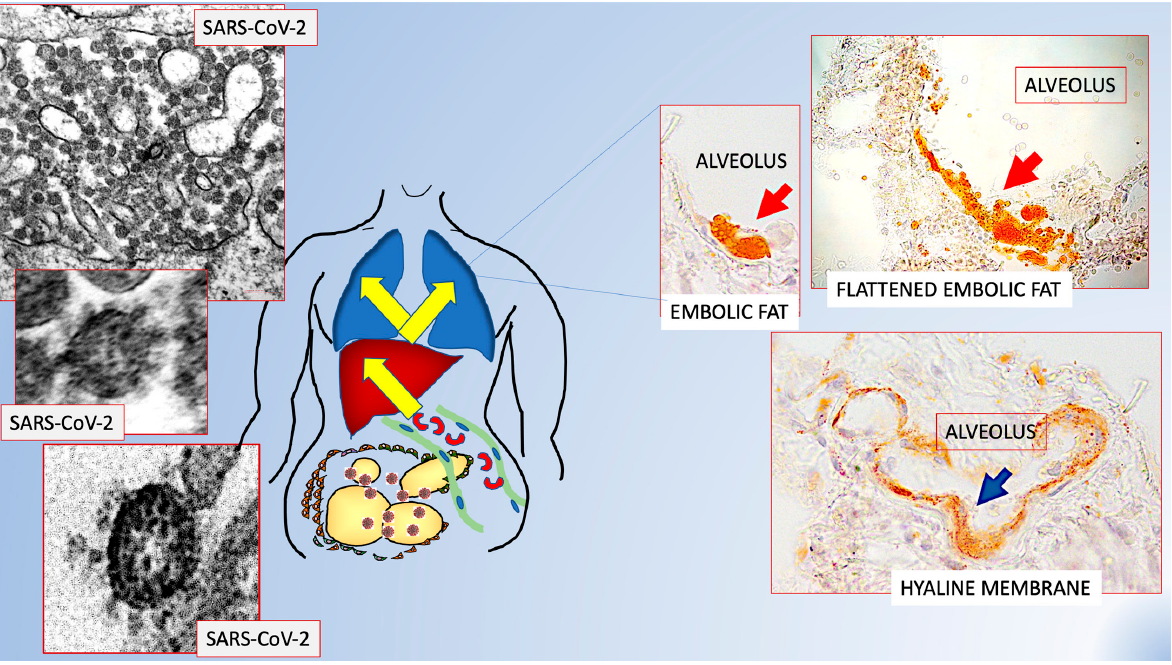
Figure 2. Scheme showing the possible role of fat embolism in COVID-19. Schematic representation of data from refs [39,40] that offer a possible explanation to the poorer prognosis for visceral obesity and sudden bilateral pneumonia in patients suffering from COVID-19. Visceral fat hyperinflammation could cause the fat embolism found in 100% of lungs of COVID-19+ patients. Original figures from Refs [39,40] with